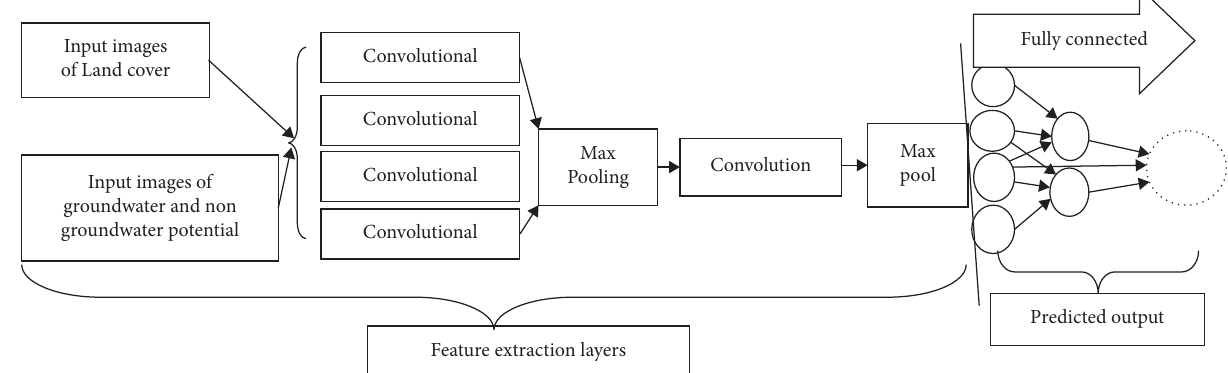
Figure 2: The general working principles of CNN [10, 23,